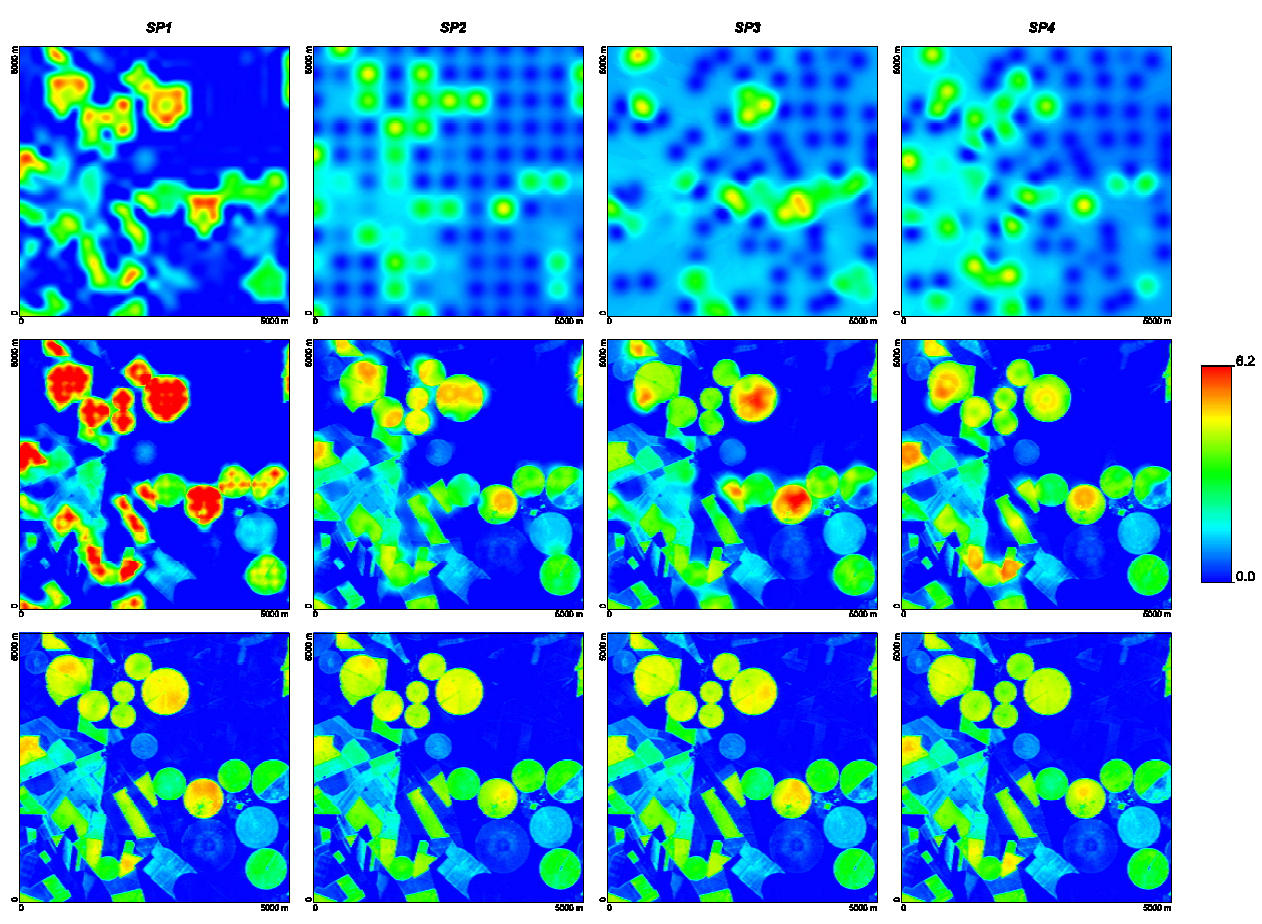
Figure 11. LAI maps derived from the OK (left), CKC (center) and KED (right) models for the four sampling schemes.